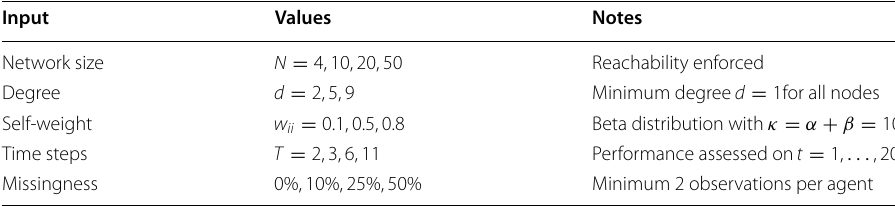
Values for factors used in the simulation study